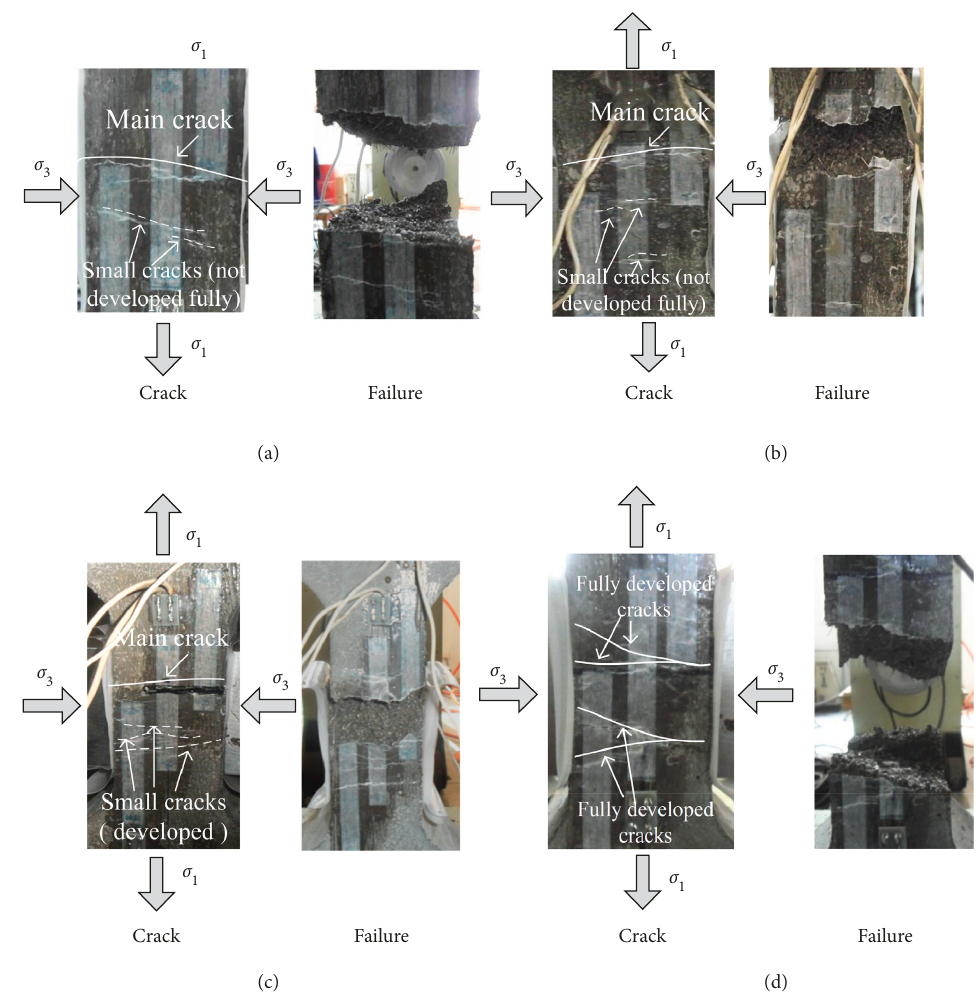
Figure 7: Failure modes of RPC C-T specimens under (a) | σ